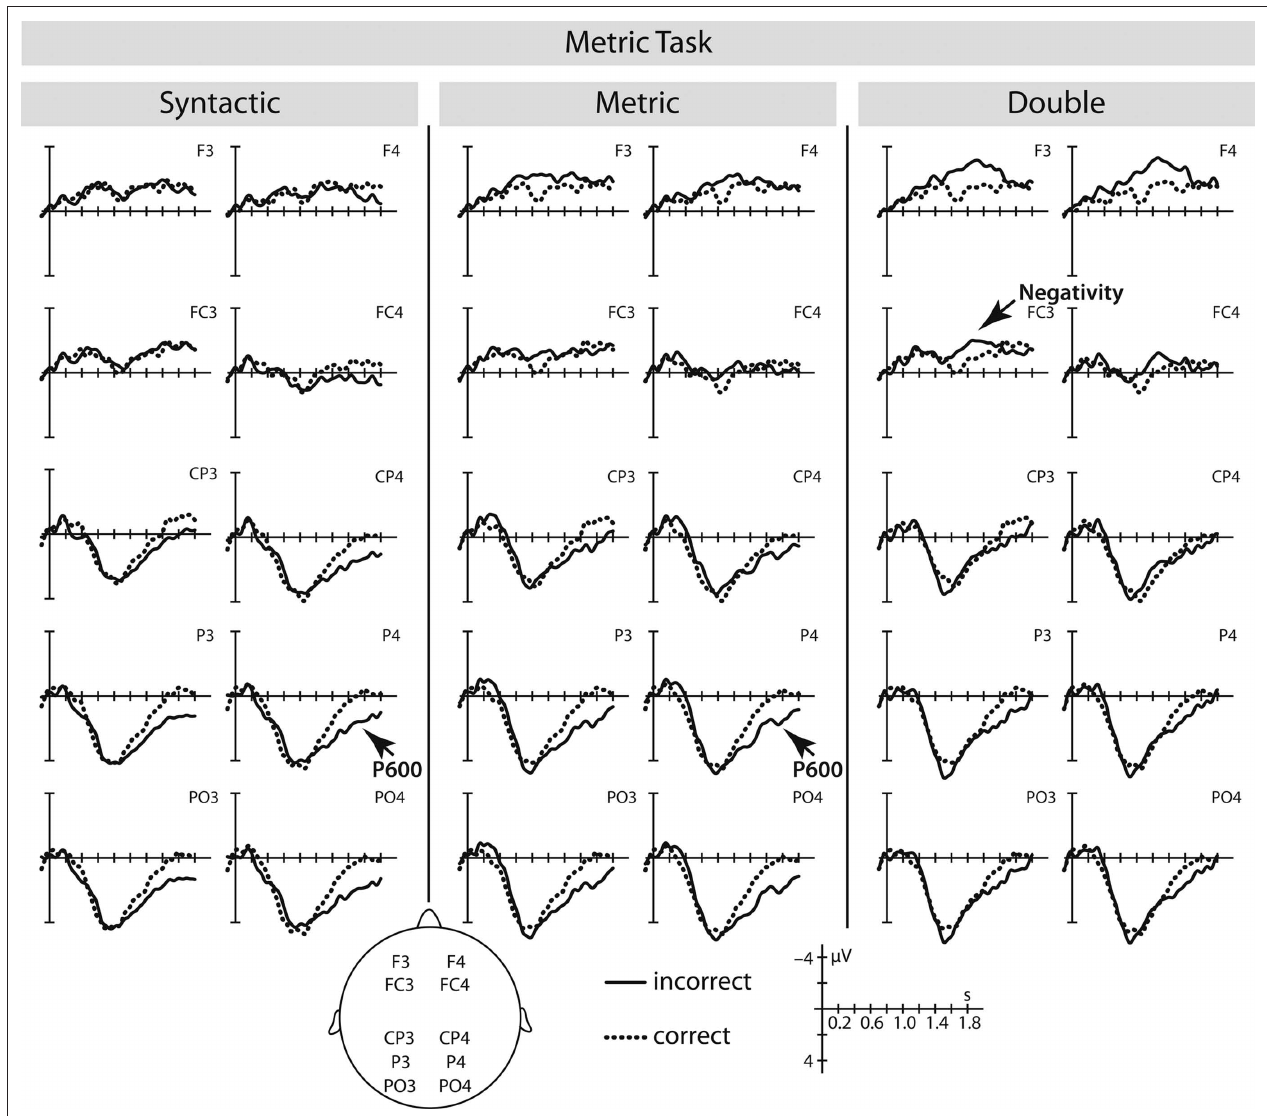
Figure 5 | Metric task – Spanish L2 learners: erPs elicited by the critical main verb in the syntactic, metric, and the double violation condition. Waveforms show the average for correct and the particular violation condition from 100 ms prior to the item onset up to